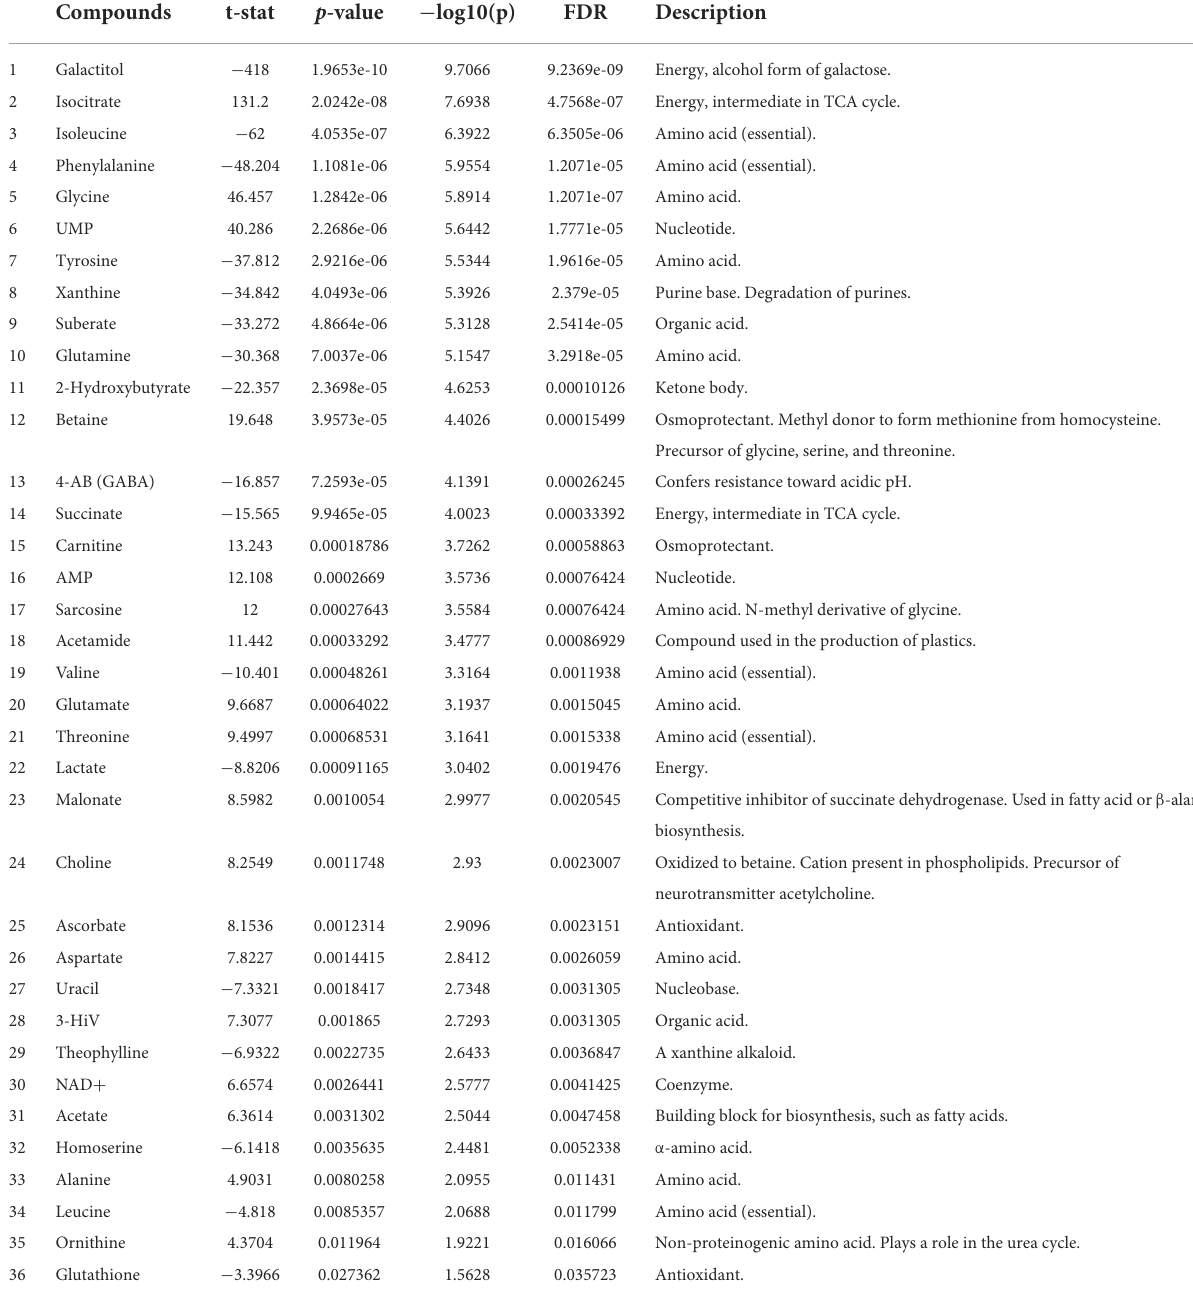
TABLE 1 Important features selected by t -tests for separation of L-OP50 and